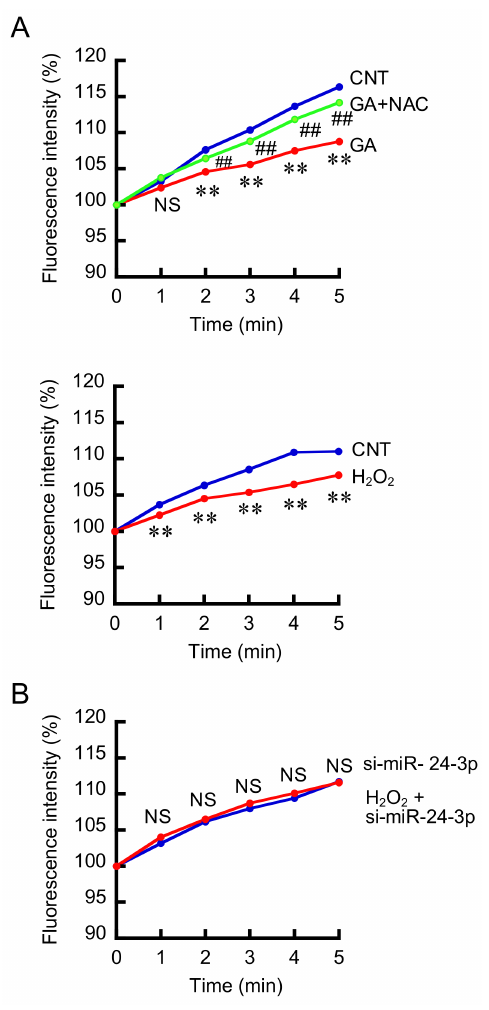
Figure 4. Effects of TRPM6 expression modulators on the elevation of [Mg 2+ ] i . ( A ) NRK-52E cells were treated in the absence (CNT) or presence of 500 µ g/mL GA, 2 mM NAC, and 50 µ M H 2 O 2 for 24 h. [Mg 2+ ] i was measured using a fluorescence microplate reader. The extracellular solution was changed to HBSS containing 5 mM MgCl 2 at 0 min. [Mg 2+ ] i was measured using a fluorescence microplate reader and represented as percentage of 0 min. ( B ) The cells transfected with si-Neg or si-miR-24-3p were treated with 50 µ M H 2 O 2 for 24 h. [Mg 2+ ] i was represented as percentage of 0 min. n = 5–6. ** p < 0.01 compared with CNT. ## p < 0.01 compared with GA. NS p > 0.05 compared with CNT or